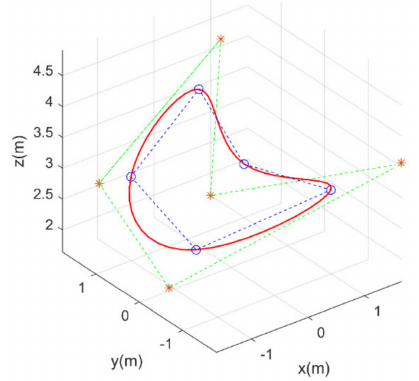
Figure 6. A 3d cubic (k = 3) B-Spline